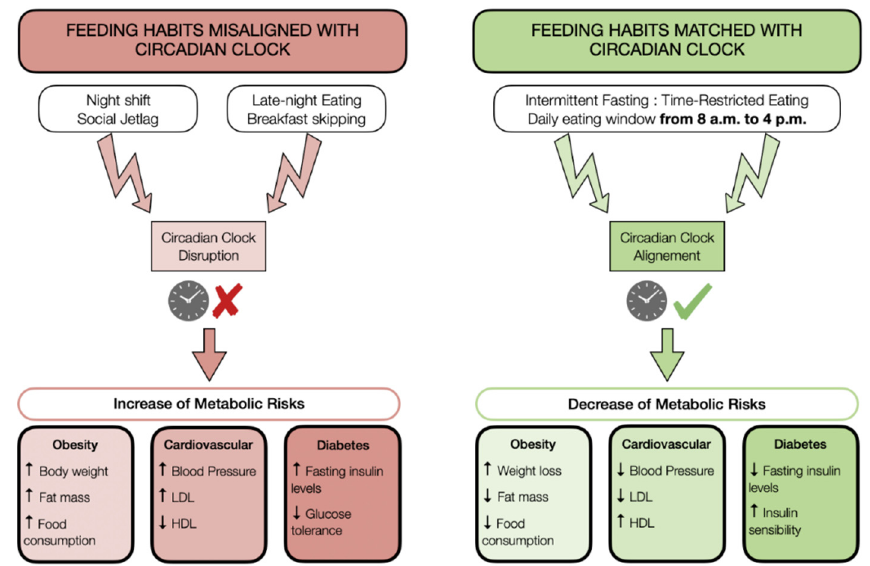
Figure 2. Impacts of food habits on metabolism are connected with the circadian clock. The way that people eat is essential for metabolic health. When food habits (timing and number of meals per day) are misaligned with the circadian clock, they prevent an increased risk of obesity, cardiovascular disorders, and diabetes. On the other hand, practicing time-restricted fasting where the eating window is aligned with circadian rhythms improves metabolic health.